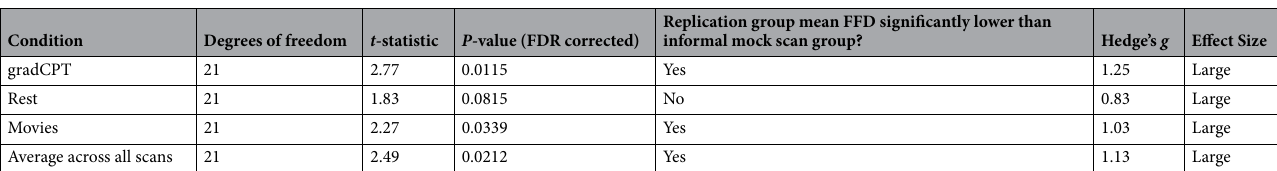
Table 4. Effect size and significance testing of replication group compared to the informal mock scan